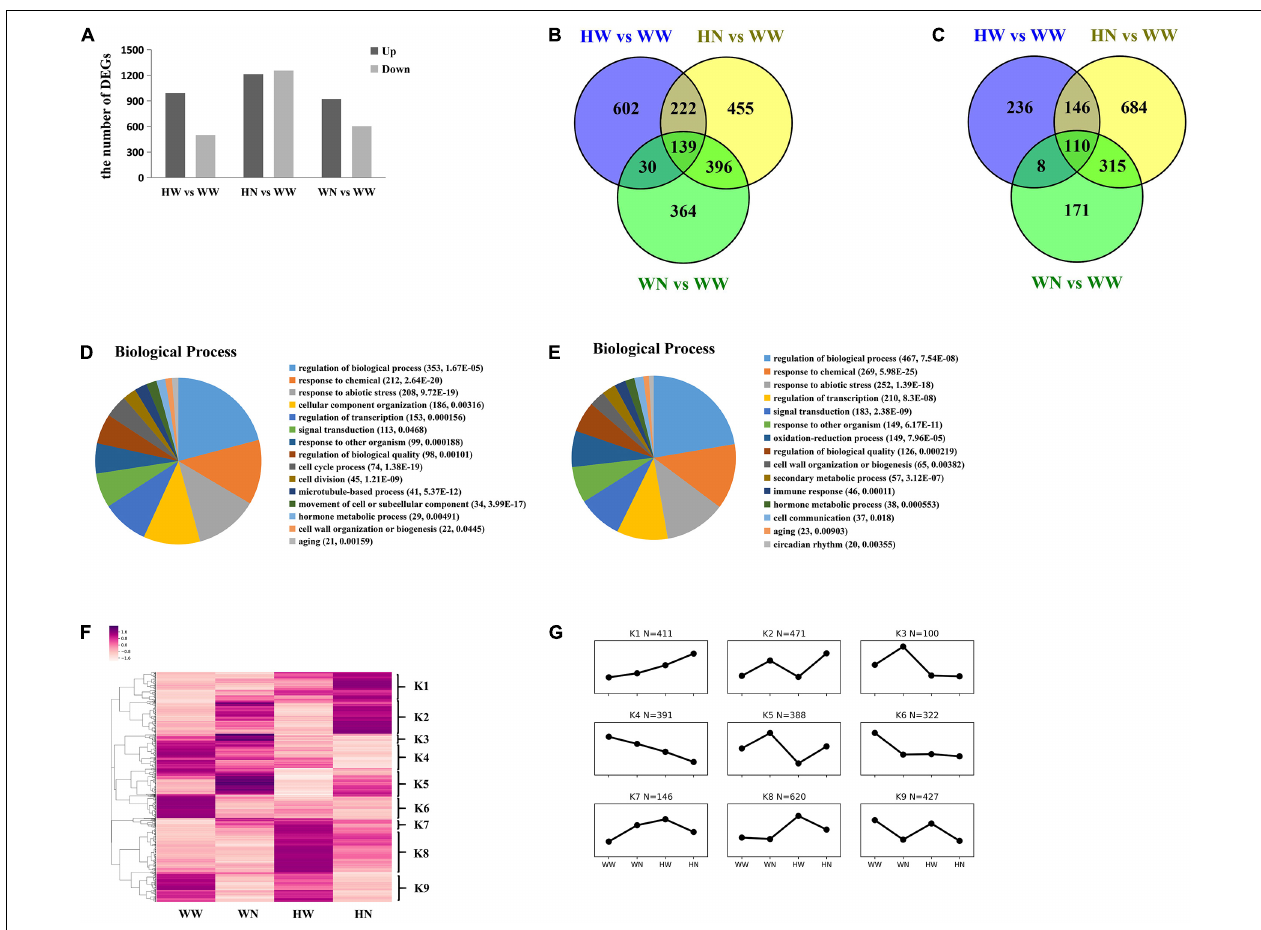
FIGURE 2 | Transcriptome analysis of Arabidopsis leaves under WW, WN, HW, and HN treatments. (A) In HW vs. WW, 993 DEGs were up-regulated, whereas 500 DEGs were down-regulated. In HN vs. WW, 1212 DEGs were up-regulated, whereas 1255 DEGs were down-regulated. In WN vs. WW, 922 DEGs were up-regulated, whereas 604 DEGs were down-regulated. (B) Venn diagram of DEGs up-regulated in WN vs. WW, HW vs. WW, and HN vs. WW. There were 602 unique DEGs in HW vs. WW, 455 unique DEGs in HN vs. WW, and 364 unique DEGs in WN vs. WW. There were 361 DEGs common to both HW and HN, 169 DEGs common to both HW and WN, and 535 DEGs common to both HN and WN. (C) Venn diagram of DEGs down-regulated in WN vs. WW, HW vs. WW, and HN vs. WW. (D) Biological process in HW vs. WW; (E) biological process in HN vs. WW. DEGs were identified by DESeq2 using Bioconductor (http://www.bioconductor. org/) based on a comparison across all samples under control or HW and control or HN conditions with FDR less than 0.05. The Goatools (v0.8.9) python package was used for GO terms enrichment with the Arabidopsis association files downloaded from TAIR10. (F) 1493 DEGs in HW vs. WW and 1766 DEGs in HN vs. WW clustered by heat-mapping under WW, WN, HW, and HN treatments ( p ≤ 0.05). (G) Nine groups of genes were identified based on the heatmap dendrogram. Averaged values for each condition in every group were used to generate the line chart, which represents the comprehensive expression patterns of each group. WW, pretreated with water and not salt-stressed; WN, pretreated with water and salt-stressed; HW, pretreated with H 2 O 2 and not salt-stressed; HN, pretreated with H 2 O 2 and